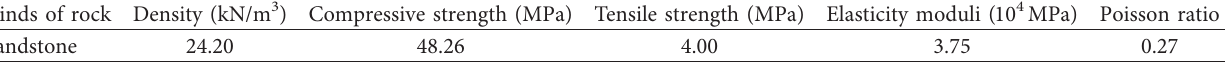
Table 1: Physical and mechanical parameters of rock.